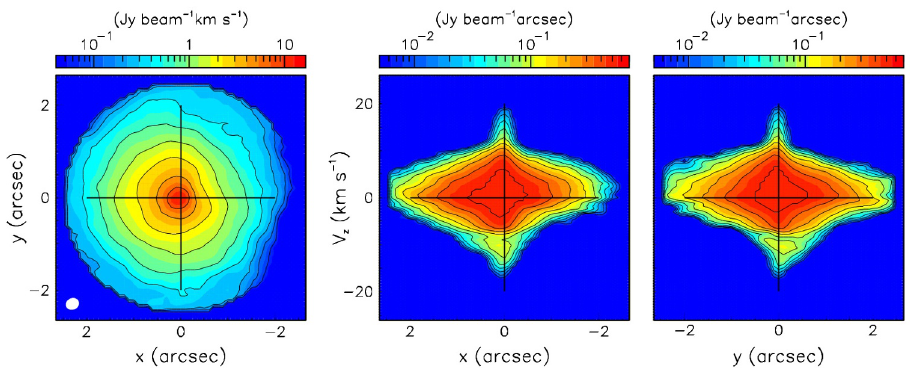
Figure 2 : EP Aqr: Projections of the SiO data-cube on ( x, y ) (left), ( x, V z ) (middle) and ( y, V z ) (right). SO 2 emission does not show any evidence for such high velocity components. Instead, the map of the mean Doppler velocity of SO 2 (Figure 3) suggests the presence of rotation. Distributions of the Doppler velocity as a function of position angle ψ measured counter- clockwise from the y axis (Figure 3 right) is well described by a sine wave; its phase shift nearly cancels, meaning that the axis of rotation projects on the sky plane along the y axis, implying the absence of a significant anisotropy, polar or equatorial, of the expansion velocity [18].